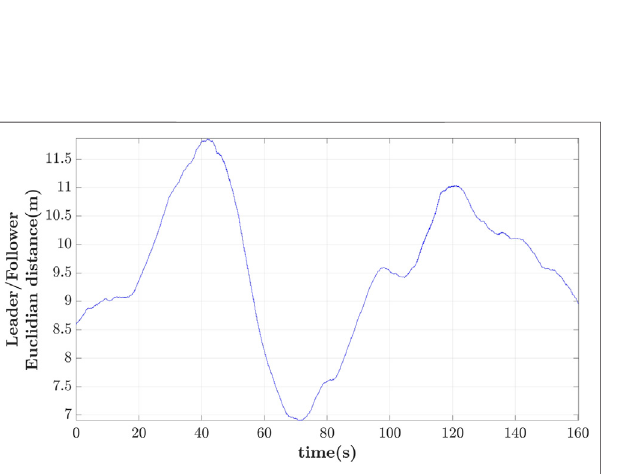
FIGURE 8 | Visual vs. Motion Capture System induced pose measurement error.